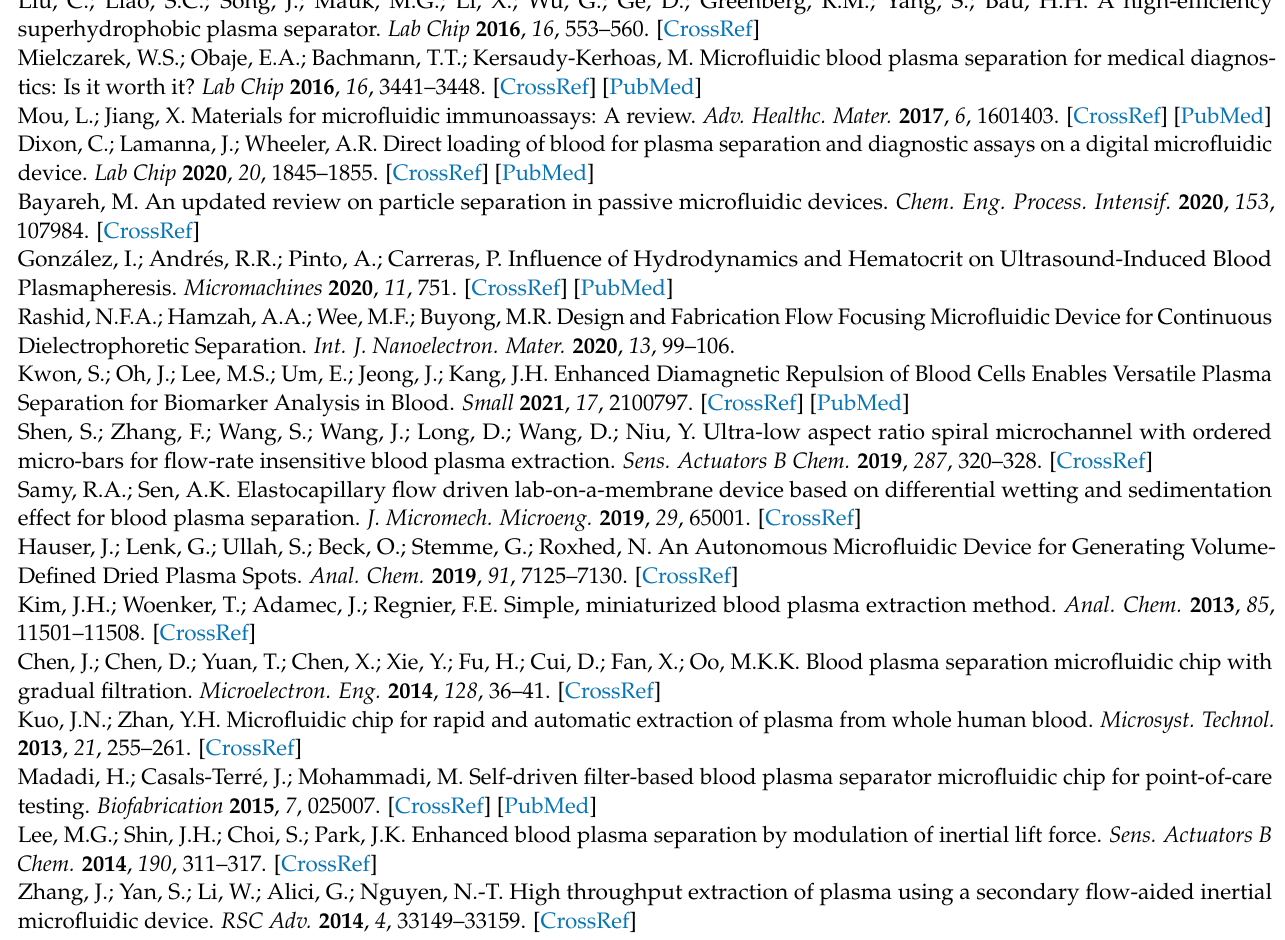
assembled microfiltration unit; Figure S2: Combined score separation index heat maps evaluated according to Equation (8) as a function of different plasma purity and free Hgb threshold values; Figure S3: Maximum pressure measured in the MFU as a function of the extracted plasma volume, inlet blood flow rate, Hct in and the kind of